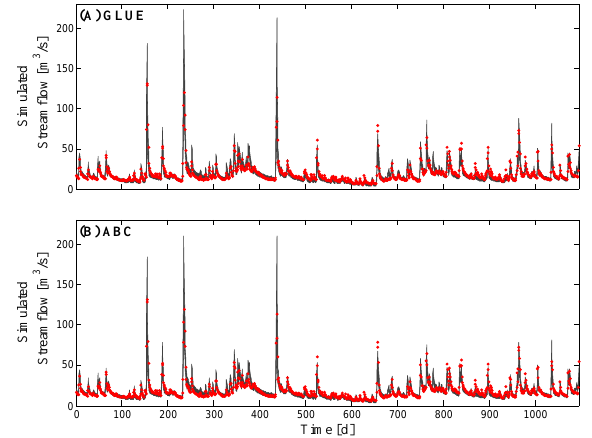
Fig. 8. SAC-SMA derived 95% streamflow simulation uncertainty ranges (grey region) for a three-year portion of the evaluation period of the French Broad river basin using the (A) GLUE and (B) ABC derived posterior parameter distribution. The observed discharge data are indicated with the solid red dots.